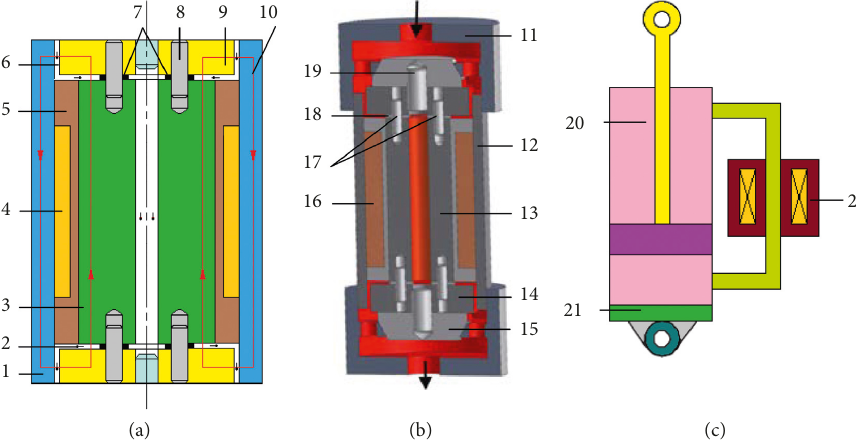
Figure 37: (a) The structure of an MR valve with annular and circular disk-type fluid flow resistance gaps [94]. (b) MR valve with both annular and radial flow path [95, 96]. (c) Schematic of an MR fluid damper [94]. 1, magnetic cylinder; 2, circular disk-type flow resistance gap; 3, valve core; 4, induction coil; 5, nonmagnetic bobbin; 6, annular flow resistance gap; 7, nonmagnetic washer; 8, nonmagnetic pin; 9, magnetic circular disk; 10, magnetic flux; 11, nonmagnetic head cover; 12, valve housing; 13, valve core; 14, magnetic disk; 15, cap; 16, coil; 17, nonmagnetic pin 1; 18, nonmagnetic washer; 19, nonmagnetic pin 2; 20, MR fluid; 21, accumulator; 22, controllable valve.